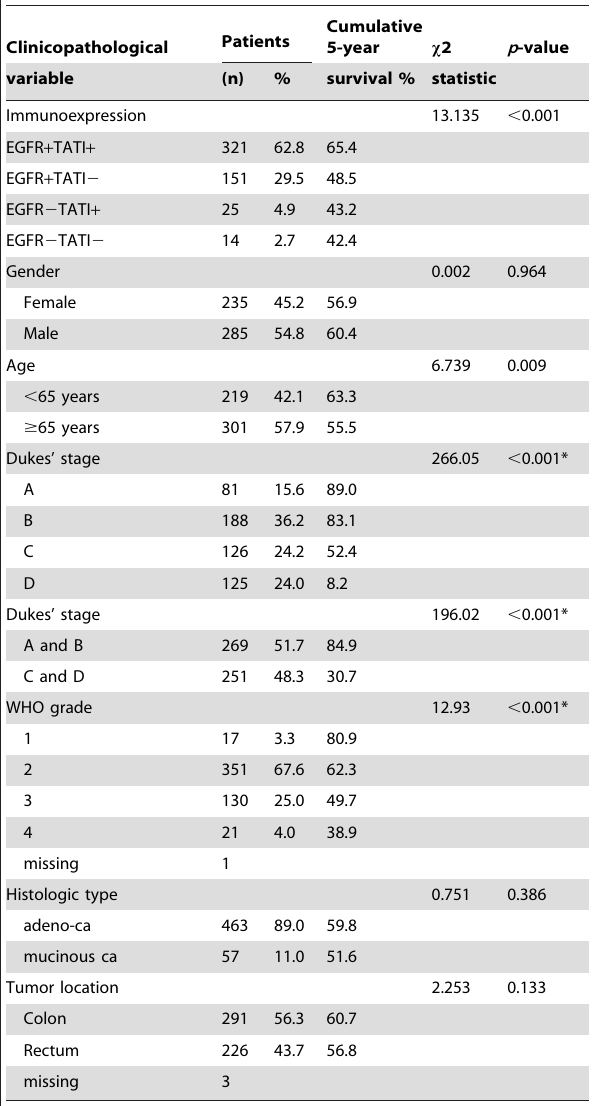
Table 5. Univariate analysis of correlations between preoperative characteristics and survival with Kaplan-Meier life-table and logrank test analyses.